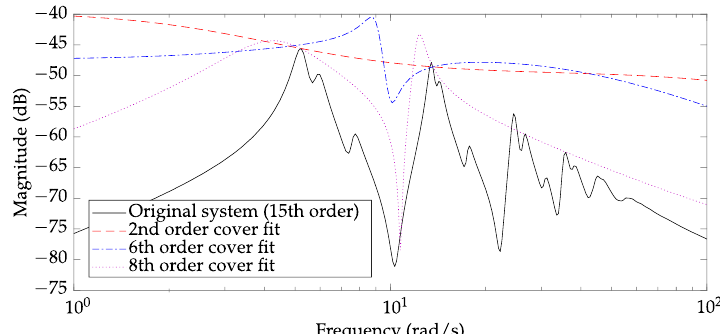
Figure 12. Examples of the different low-order weights (filters)—modelled using logarithmic- Chebyshev filter design—that cover the frequency response of a high order dynamical system in the desired frequency range. All lower order filters are stable and modelled in such a way to have gain larger than the original high order dynamical system. This makes such a filter useful when modelling unstructured uncertainties (e.g., additive